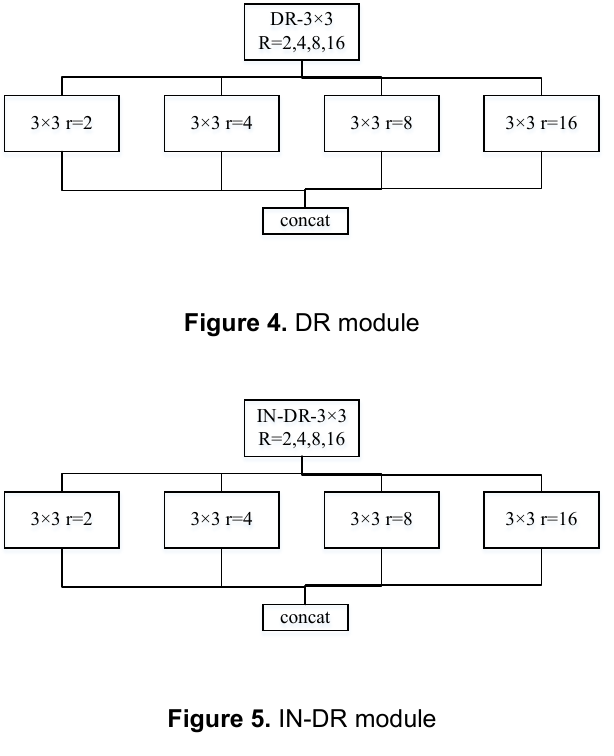
Figure 5. IN-DR module